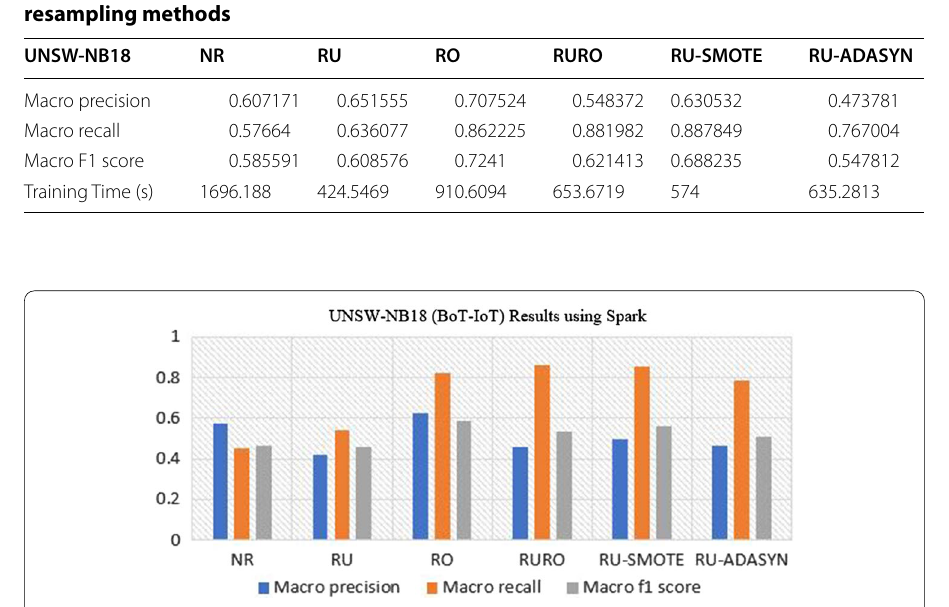
Fig. 11 ANN classification results for UNSW-NB18 (BoT-IoT) on AWS with Spark for various resampling